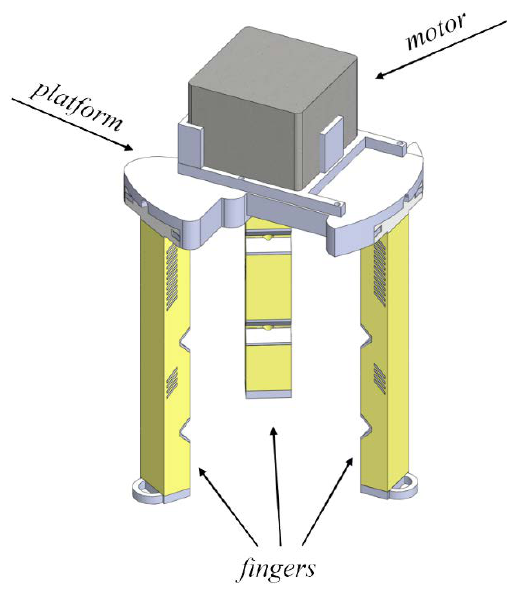
Figure 12. Design of the fully 3D-printed gripper with three equally spaced soft fingers and stepper motor at the top.